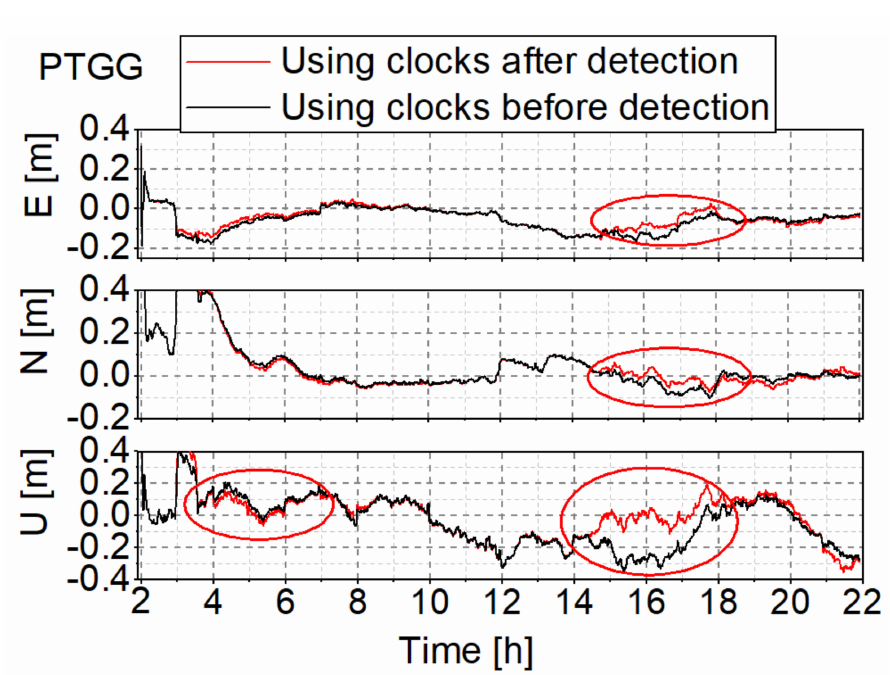
Figure 13. Positioning errors of the real-time kinematic PPP at the station PTGG on 4 January